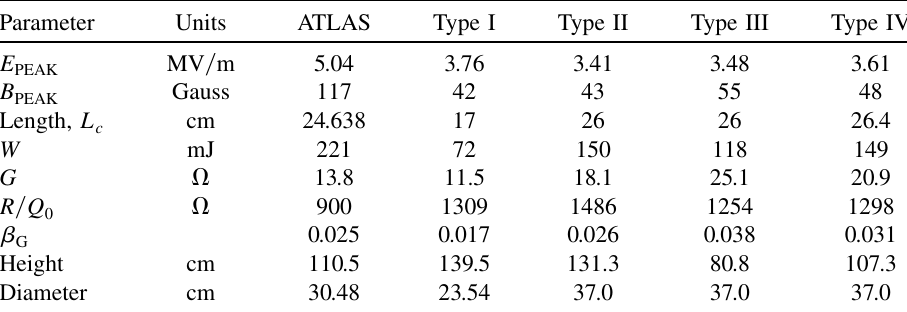
(cid:1) 1 MV = m . ACC